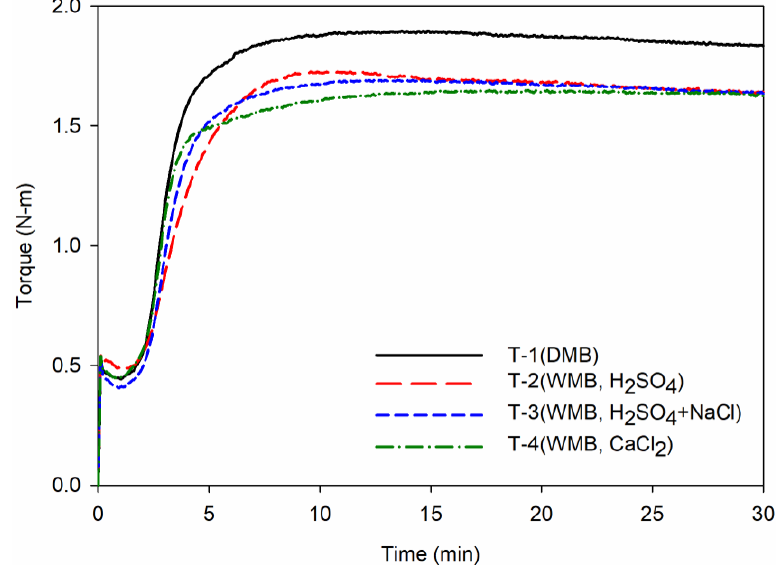
Figure 5. Cure characteristics of the T-1 to T-4 compounds: Each graph shows cure characteristics behavior of compounds according to the cure time. The black line shows the cure behavior of the T-1 DMB compound, the red line shows the T-2 WMB compound, the blue line shows the T-3 WMB compound, and the green line shows the T-4 WMB compound. Table 10. Cure characteristics and crosslink density of the T-1 to T-4 compounds.